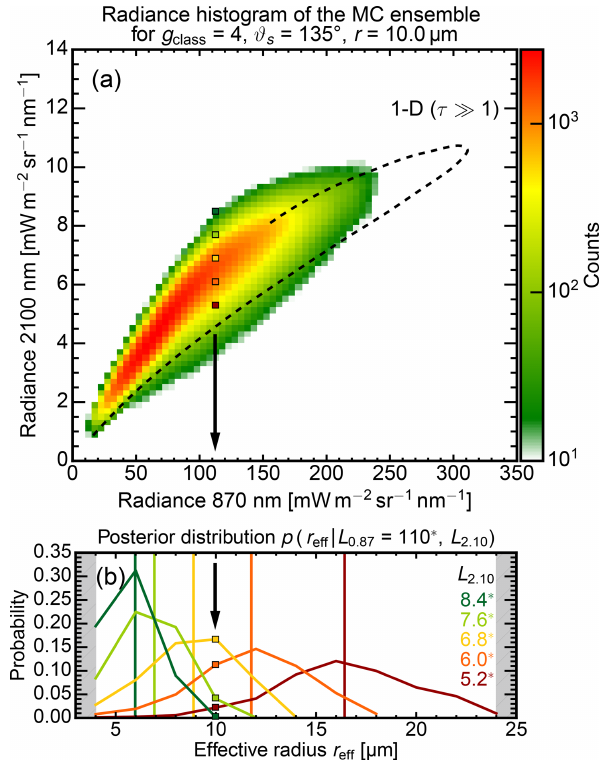
Figure 19. (a) Radiance histogram ( ϑ s = 135 ◦ , g class = 4) for the 3-D forward simulation ensemble of cloud sides, which illustrates the radiance spread for the effective radius bin of r eff = 10µm. The dashed line shows reflected radiances which were calculated with DISORT (1-D RT code) for an optically thick ( τ c = 500) wa- ter cloud with a variable cloud surface inclination within the prin- cipal plane. The colored dots indicate locations within the his- togram for which the posterior distributions are shown in Fig. 19b. (b) Corresponding posterior probability for a fixed radiance L 0 . 87 = 110mWm − 2 nm − 1 sr − 1 at the non-absorbing wavelength and dif- ferent L 2 . 10 radiances at the absorbing wavelength. The vertical lines indicate the corresponding mean effective radius for each pos- terior